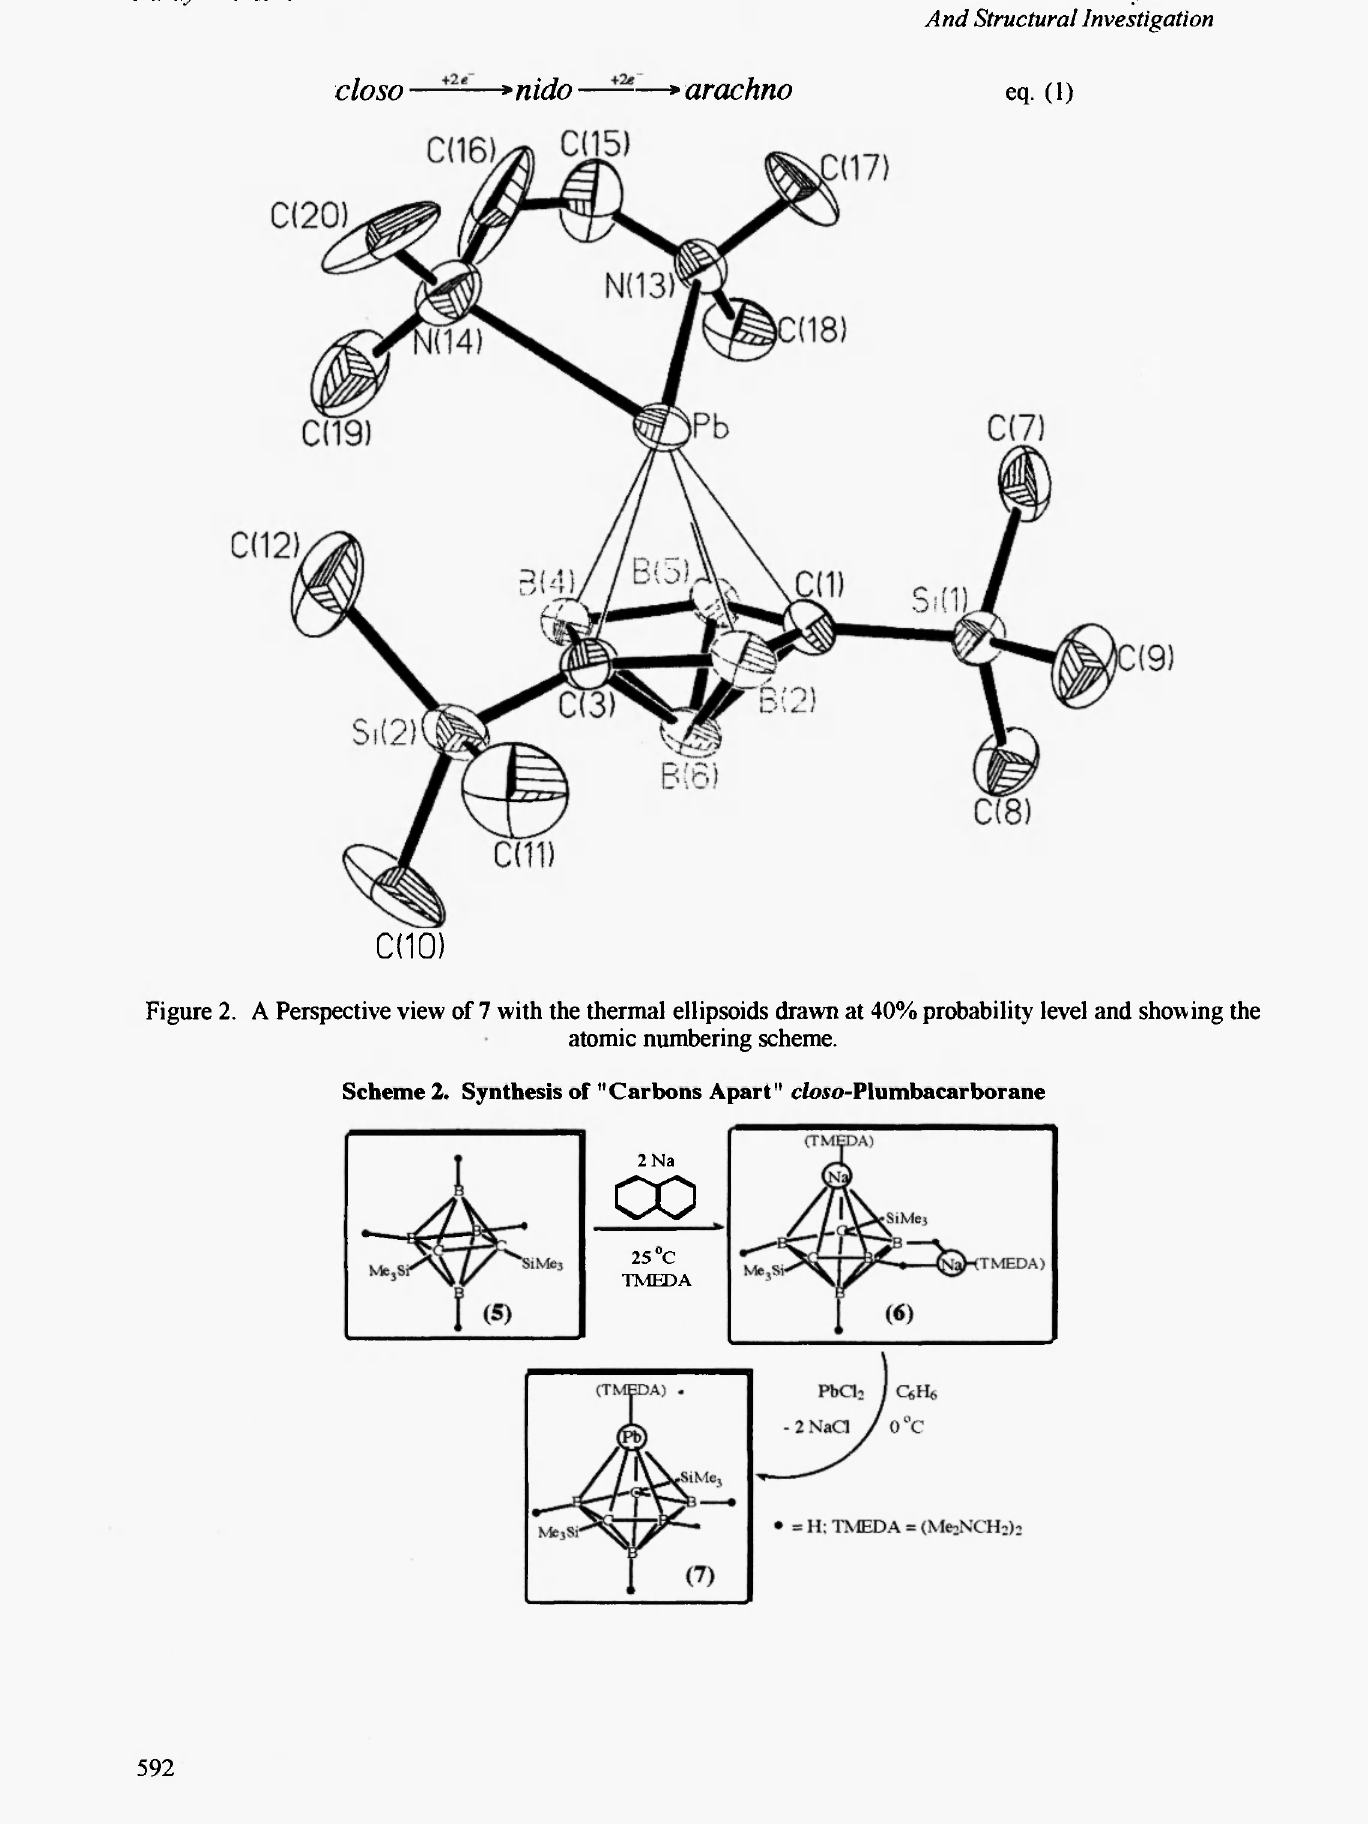
Figure 2. A Perspective view of 7 with the thermal ellipsoids drawn at 40% probability level and showing the atomic numbering